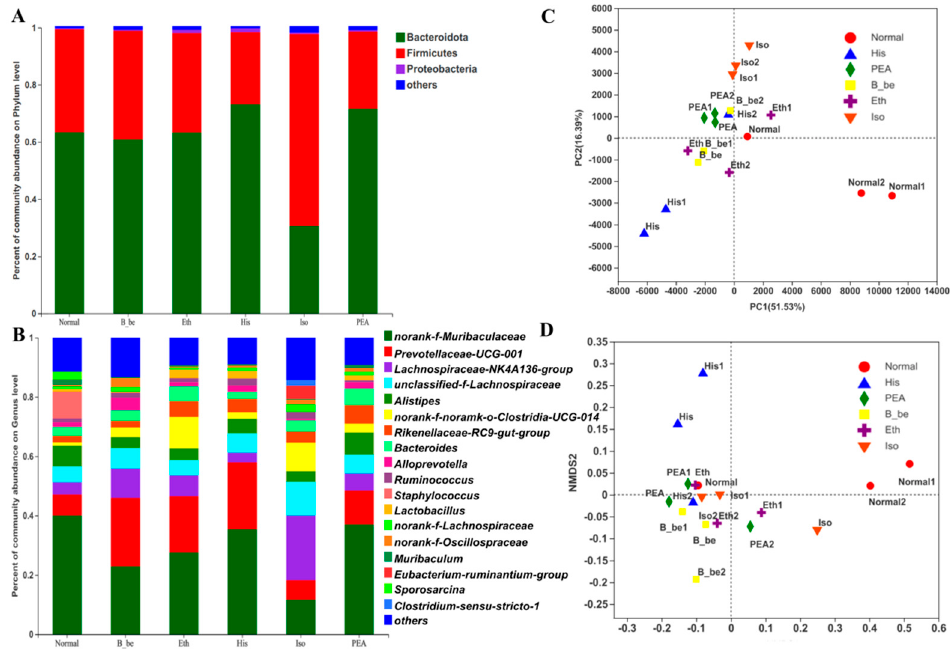
Figure 5 . The effects of His, PEA, β -be, and Iso on the community composition amd Beta diversity of gut microbiome in mice. ( A )The relative abundance plot in bacterial phyla level of the gut microbiota. ( B ) The relative abundance plot in bacterial genera of the gut microbiota. ( C ) Principal coordinate analysis. ( D ) Clustering analysis.